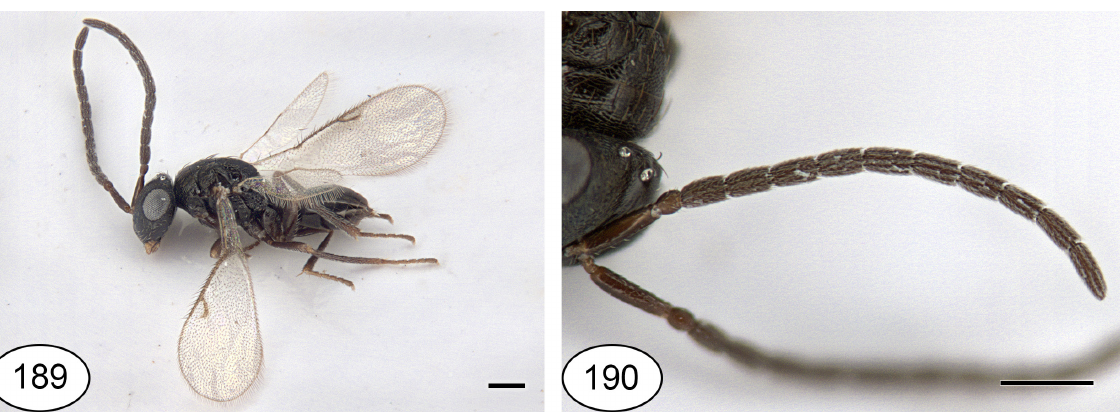
Figs 189–190. Netomocera setifera Bouček, 1988, ♂, Romania. 189 . Habitus, lateral view. 190 . Antenna. Scale bars: 0.2